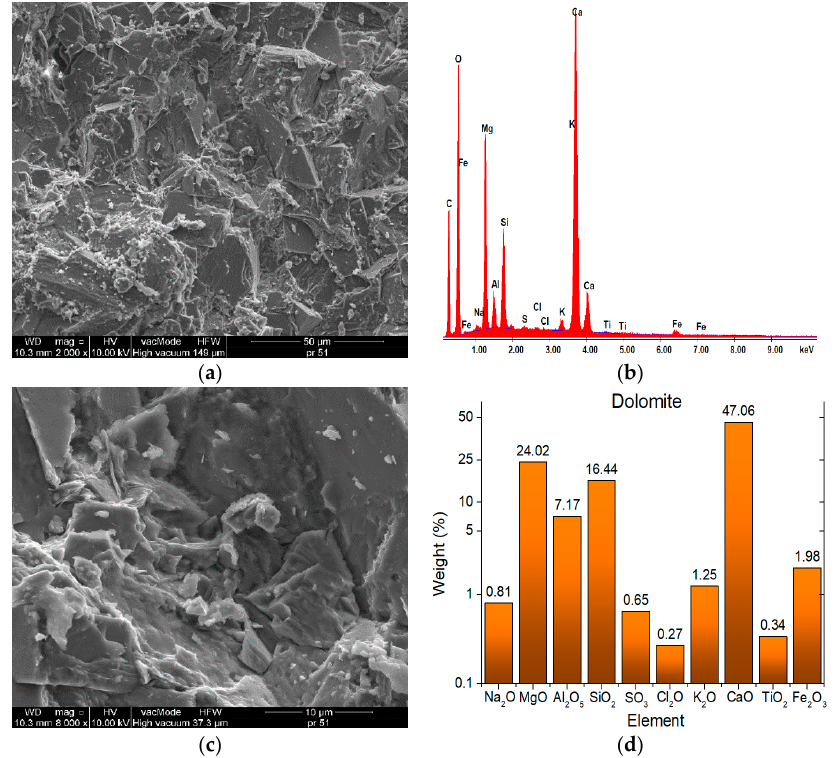
Figure 3. Dolomite SEM microstructure (2000× and 8000×) and elemental analysis results in the EDS micro area. ( a ) SEM microstructure (2000×); ( b ) composition; ( c ) SEM microstructure (8000×); ( d ) percentage composition.